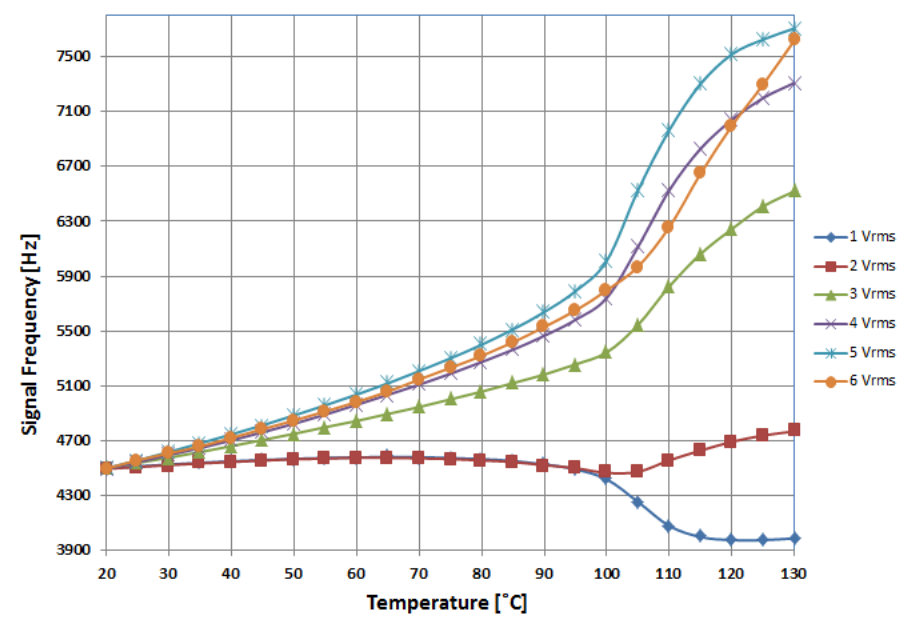
Figure 7. Variation of output frequency as a function of the temperature for different voltages applied to NLC